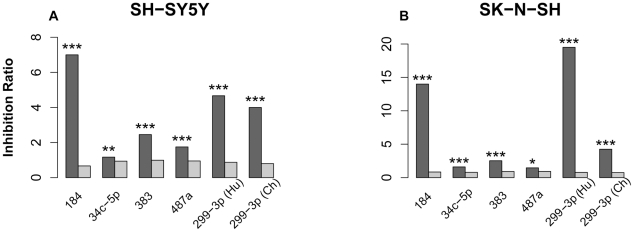
miRNA transfection effects in two cell lines.The dark grey bars depict the inhibition ratio of conserved miRNA targets, predicted using the TargetScan algorithm. The light grey bars depict the inhibition ratio of non-target genes. Inhibition ratio was calculated as the number of genes down-regulated 24 hours after miRNA transfection, divided by the number of not-down-regulated genes. For each gene, the miRNA transfection effect was calculated as a ratio of mRNA expression level 24 hours after miRNA transfection, divided by mRNA expression level 24 hours after transfection with negative controls (Materials and Methods). The significance of difference between target and non-target inhibition ratios estimated using Fisher's exact test is shown above the bars: *** - p<0.001; ** - p<0.01; * - p<0.05.